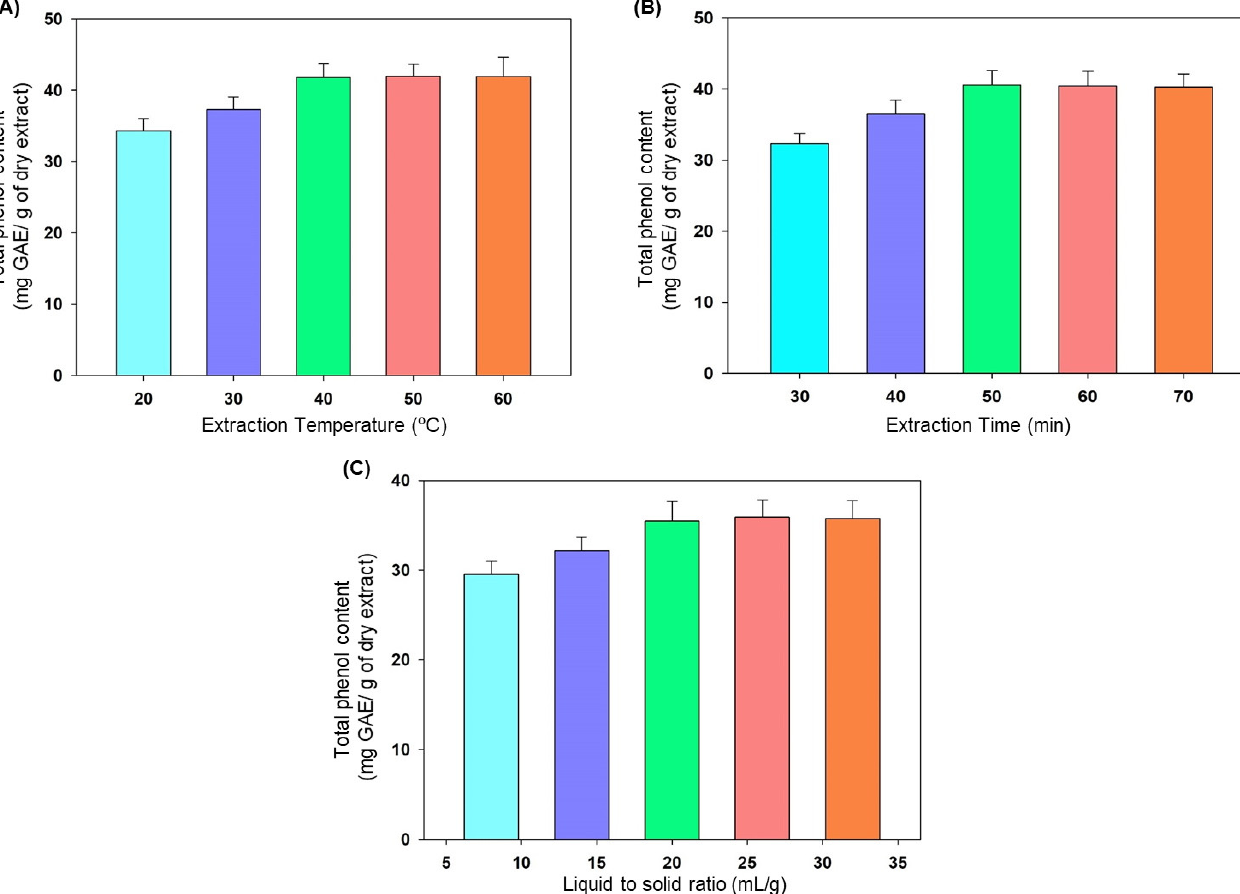
Figure 1. The effects of single factors on the total phenol content (mg GAE/g of dry extract). ( A ) Effect of extraction temperature (°C); ( B ) effect of extraction time (min); ( C ) effect of liquid-to-solid ratio (mL/g). Each value represents a mean ± SD ( n = 5).